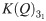
Plots of knotting probability as a function of Q during folding of UCH-L1 protein (PDB code 3IRT) in different conditions and temperatures.A: The total knotting probability K(Q)T (all possible type of knots) in the confinement. B: The knotting probability of a 31 knot (K(Q)31) in the confinement. C: The knotting probability of 52 knot (K(Q)52) in the confinement. D: The comparison of K(Q), K(Q)52 and K(Q)31 in bulk and the confinement at T = 110.